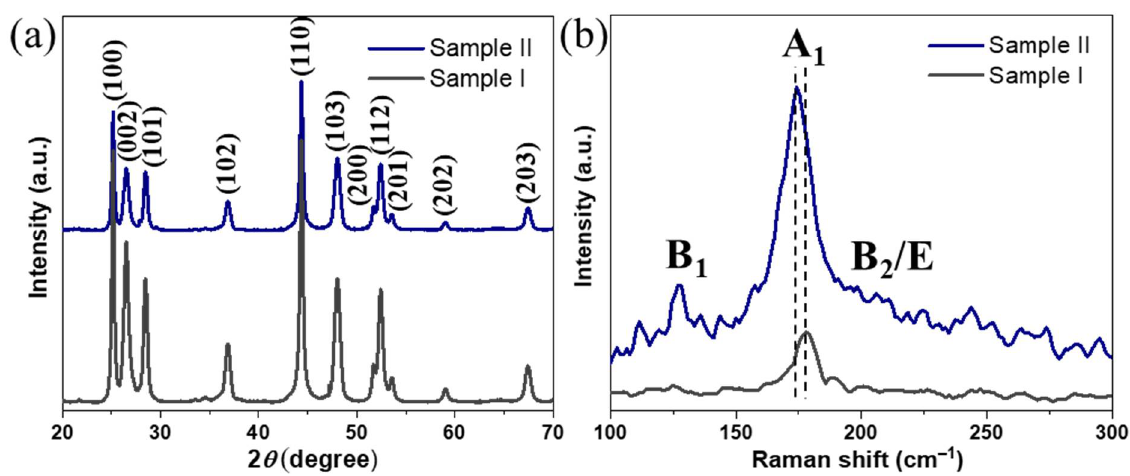
Figure 1. XRD patterns (ICDD card no. 01–078-5190) ( a ) and Raman spectra ( b ) of the synthesized nanoparticles from Figure 1. XRD diffractogram (ICDD card no. 01–078-5190) ( a ) and Raman data ( b ) of the synthesized nanoparticles (NPs) from both samples. both